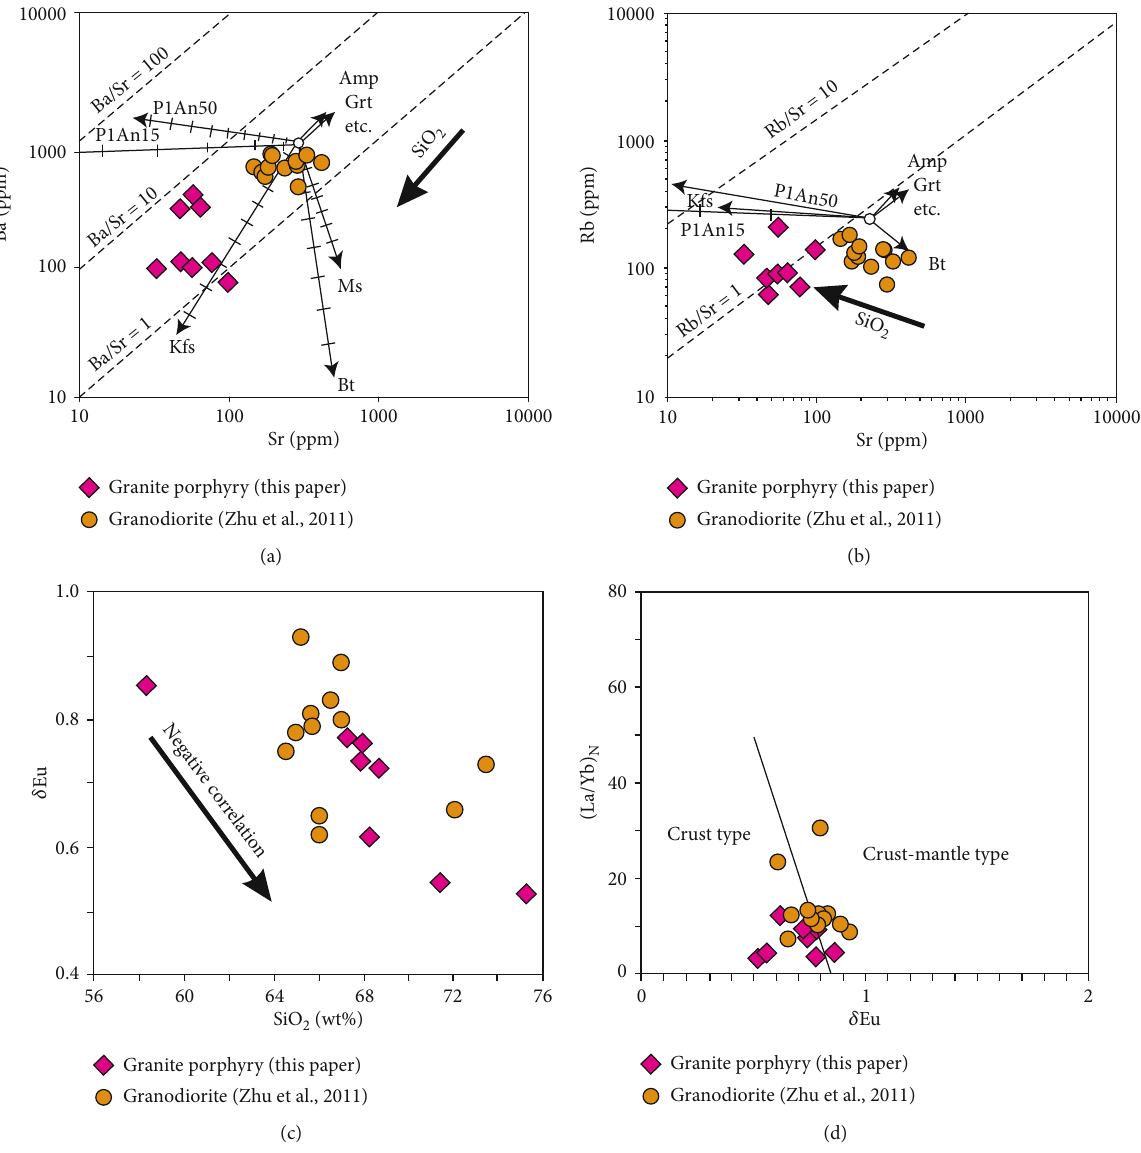
Figure 19: Plot of Sr vs. Ba (a), Sr vs. Rb (b), δ Eu vs. SiO Yangla copper deposit, Yunnan, China (after Rollinson,1993 [76], Janou š ek et al., 2004 [83], Lu et al., 2019